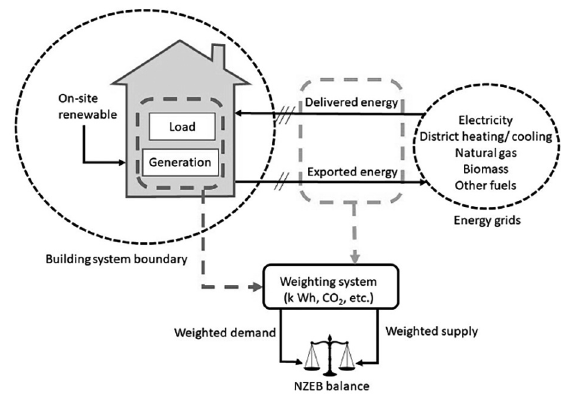
Figure 1. System structure and essential elements of NZEB (Deng et al., 2014)